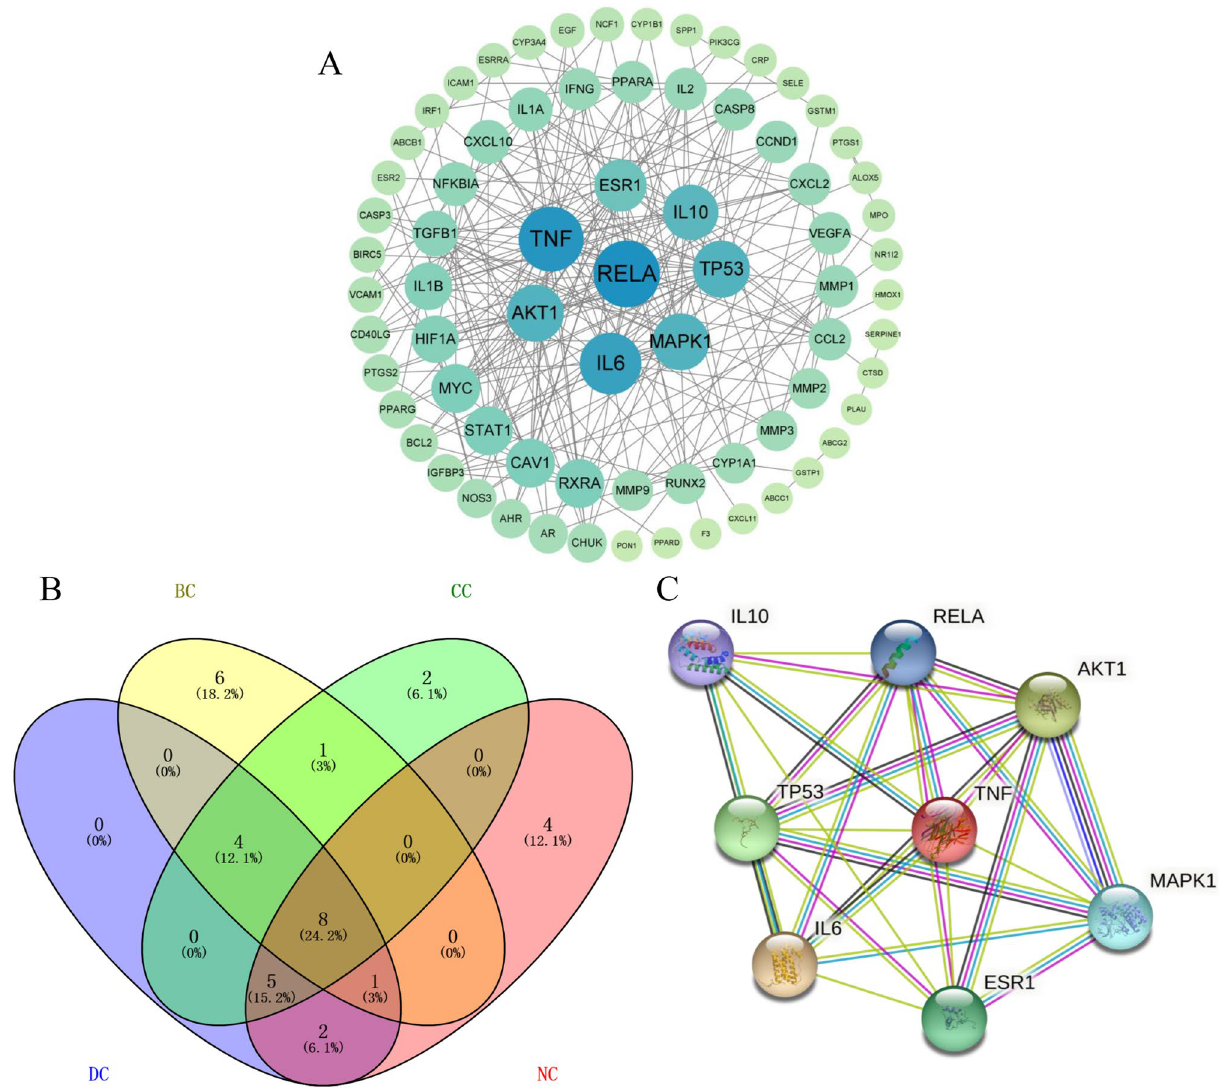
Figure 4. Construction of the PPI network and screening hub targets. ( A ) PPI network of 85 common targets. ( B ) Hub genes were screened from the PPI network using the Betweenness (BC), Closeness (CC), Degree (DC), and Network (NC) methods. ( C ) Subnetwork of the PPI network of 8 hub targets. The color and size of the nodes reflect the degree value for each protein target: the larger and darker the node, the greater the degree value. The different colored lines in the figure represent known interactions and predicted interactions (light blue: from curated databases; dark purple: experimentally determined; green: gene neighborhood; red: gene fusions; dark blue: gene co-occurrence; yellow: textmining; black: co-expression; light purple: protein